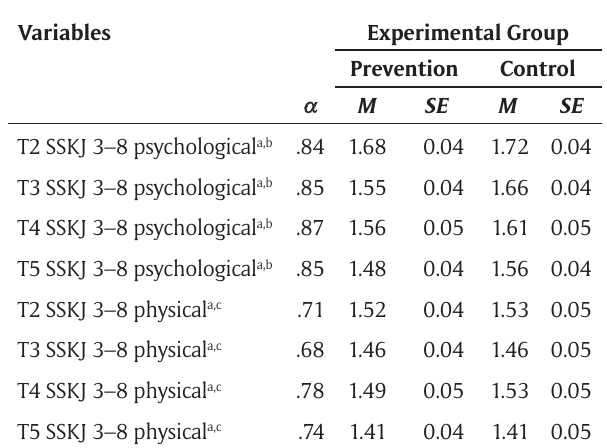
Table 2: Descriptive Statistics: Means and Standard Errors for the Main Measures.